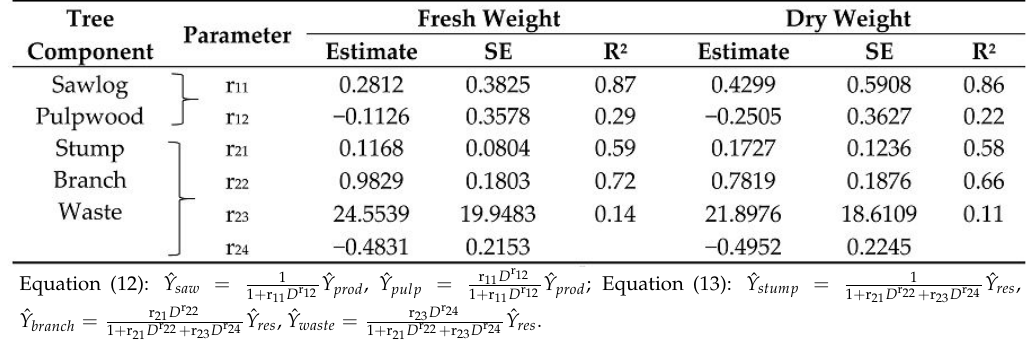
Table 8. Estimated parameters, their standard errors (SE) and R 2 for the two systems of allocative equations (Equations (12) and (13)) for product and residue fresh and dry weight as displayed in the footnote. All variables with a hat in the footnote denote the predicted values of biomass components that they